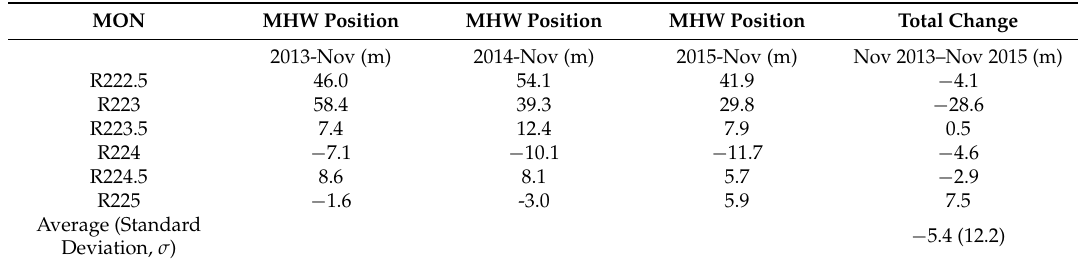
Table 1. MHW shoreline positions measured at the Florida Department of Environmental Protection (FDEP) R-monuments and changes from construction completion (November 2013) to November 2015. Shaded rows represent the project area.